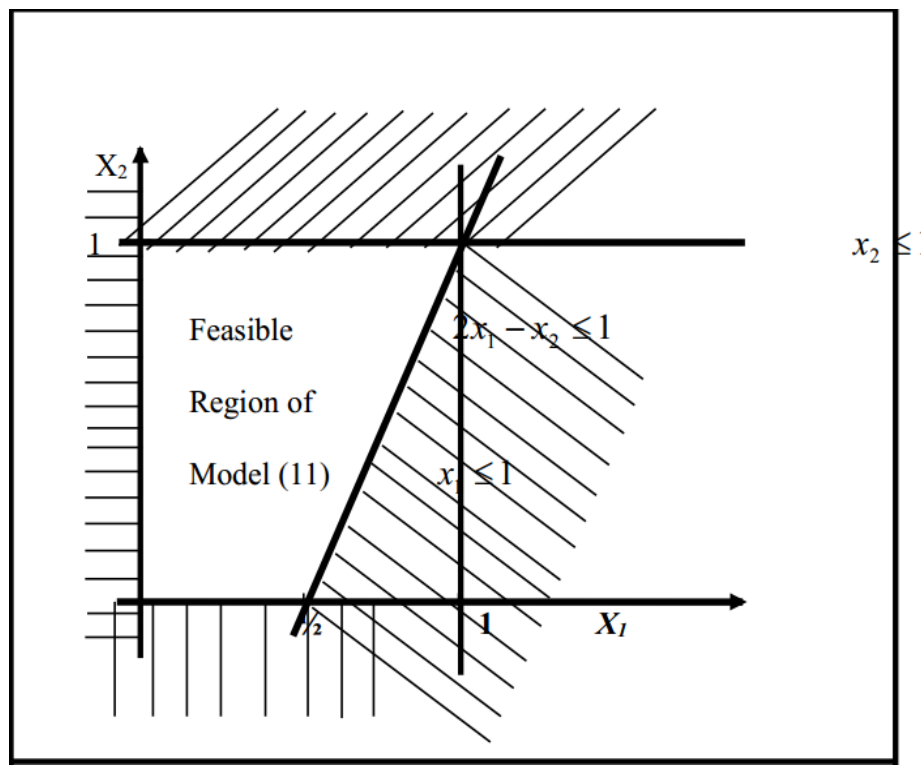
Fig. 1. Schematic presentation of the LP model